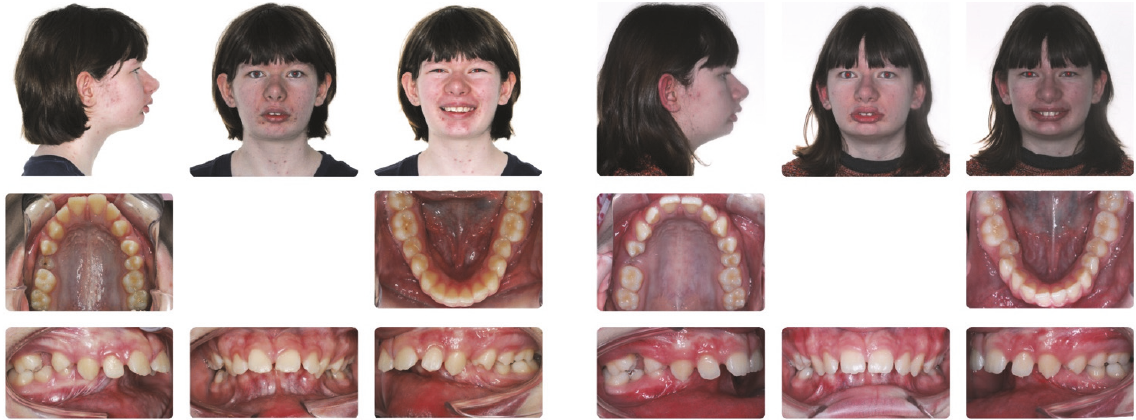
Figure 1: Facial and intraoral photographs of the identical twins.